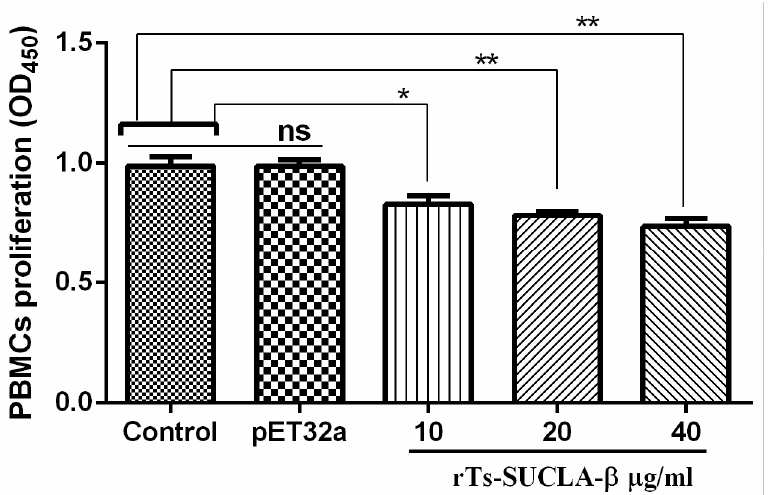
Figure 4. E ff ects of rTs-SUCLA- β on cell proliferation. PBMCs were treated with PBS (control), purified pET-32a protein and serial concentrations of rTs-SUCLA- β for 72 hours. Cell proliferation index was calculated considering the Optical Density (OD 450 ) values in PBS control as 100%. Significant differences was marked with * when p < 0.05, ** when p < 0.01 and ns (no significant difference). The data were analyzed from standard error mean of three independent experiments.